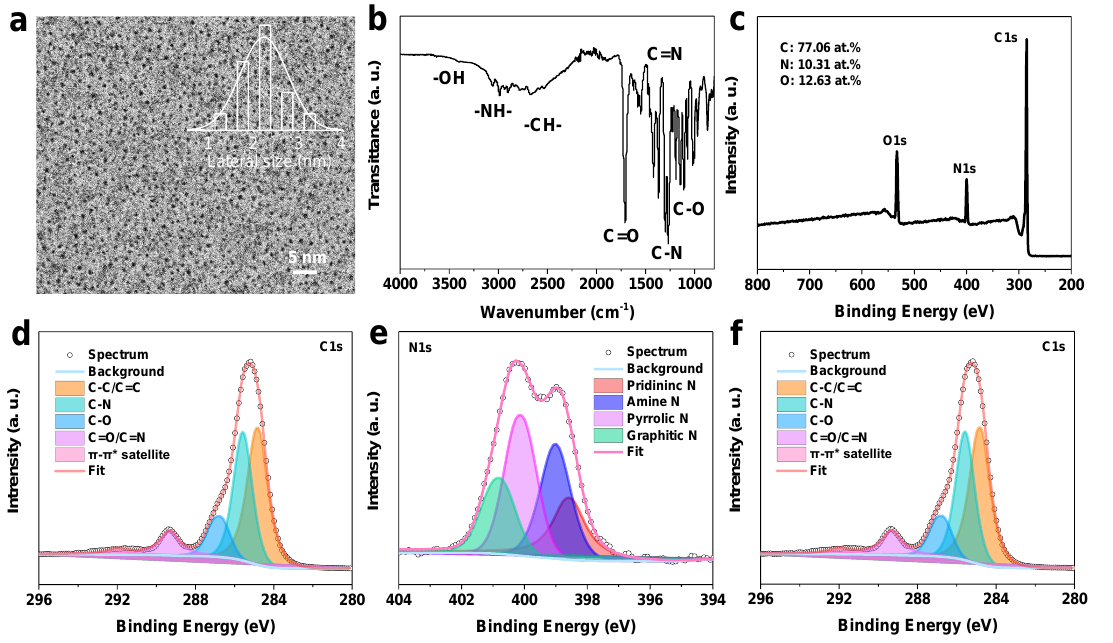
Figure 3. ( a ) TEM image and its corresponding lateral size distribution, ( b ) FT-IR spectrum, ( c ) survey XPS spectrum, ( d ) high-resolution C1s spectrum, ( e ) high-resolution N1s spectrum, and ( f ) high-resolution O1s spectrum of N-CDs.